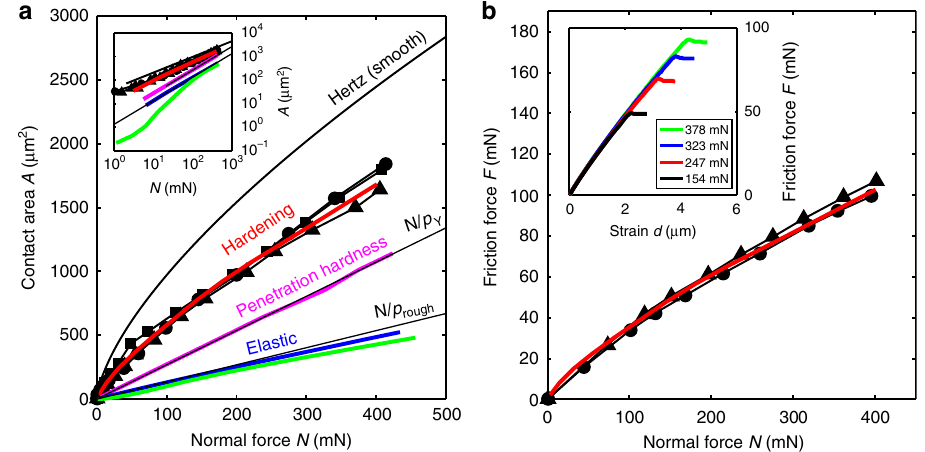
Fig. 3 Amontons ’ law and the real contact area. a Real contact area vs. normal force. The area of real contact is obtained by thresholding the fl uorescence images (Supplementary Fig. 1). Symbols show experiments on three PS spheres that have similar roughness. Solid lines show values obtained from